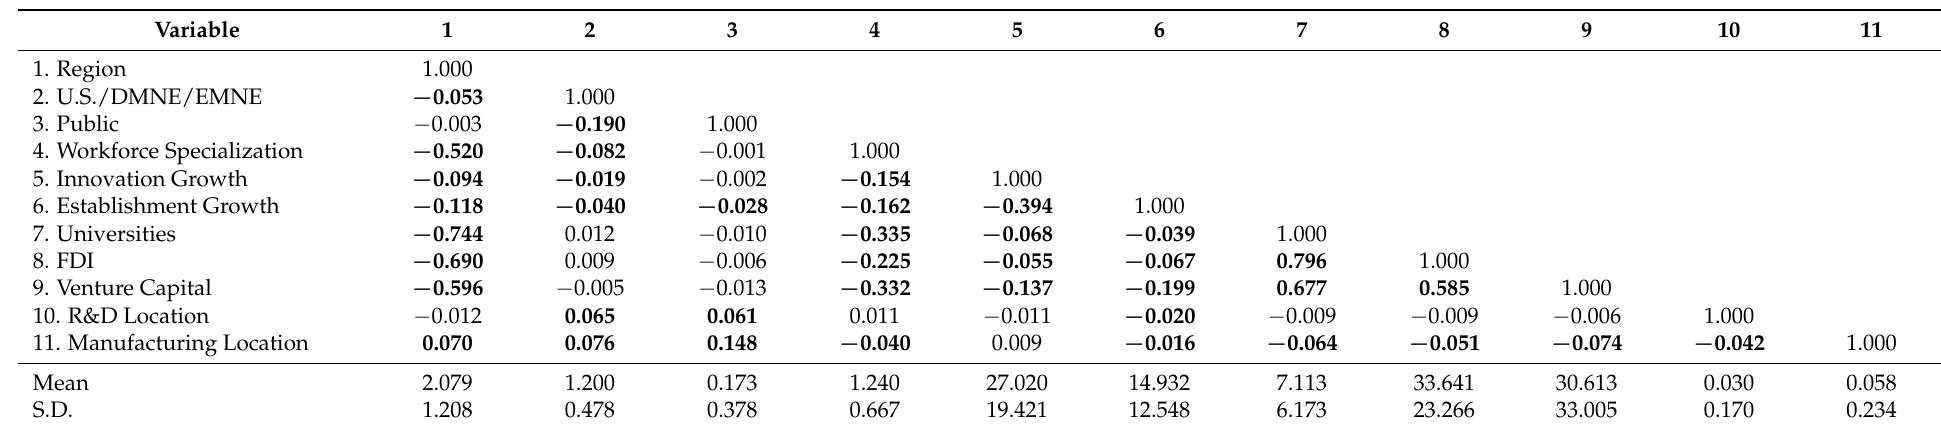
Table 3. Descriptive statistics and